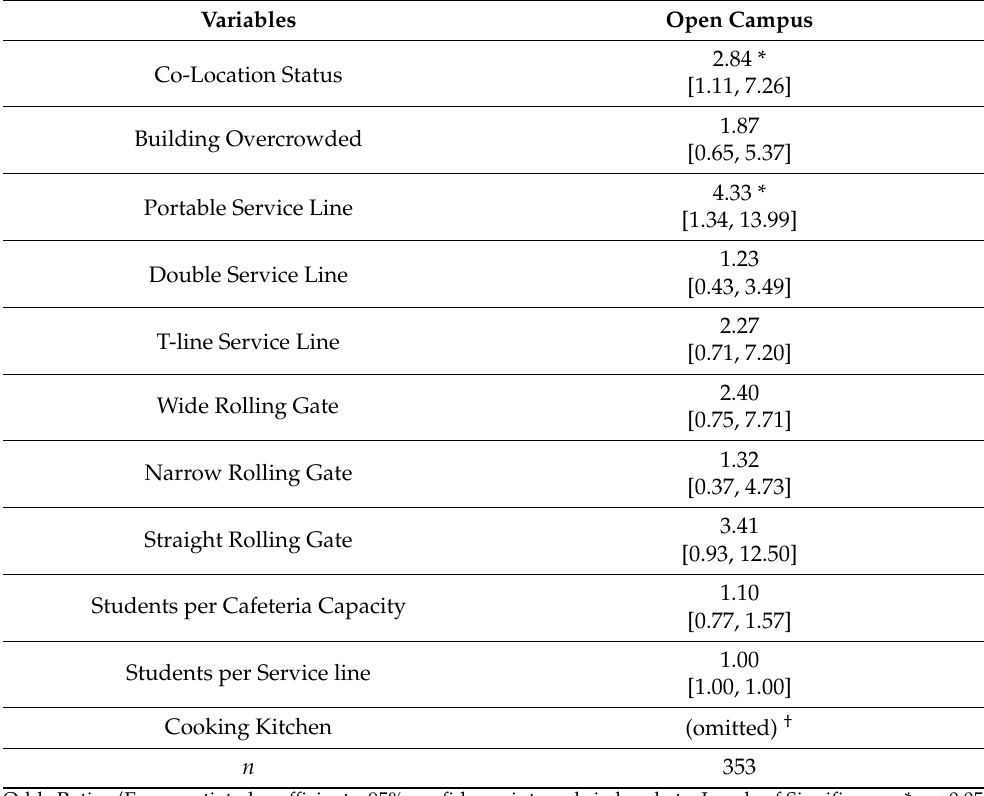
Table 4. Logistic Regression and 95% Confidence Intervals Results for Open Campus in New York City Public